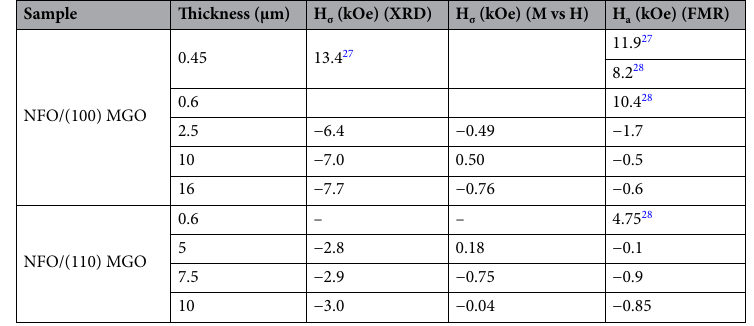
Table 5. Growth induced anisotropy field H σ = H a for LPE grown films of NFO on MGO substrates. Parameters for PLD grown submicron thick films of NFO on MGO are also listed for